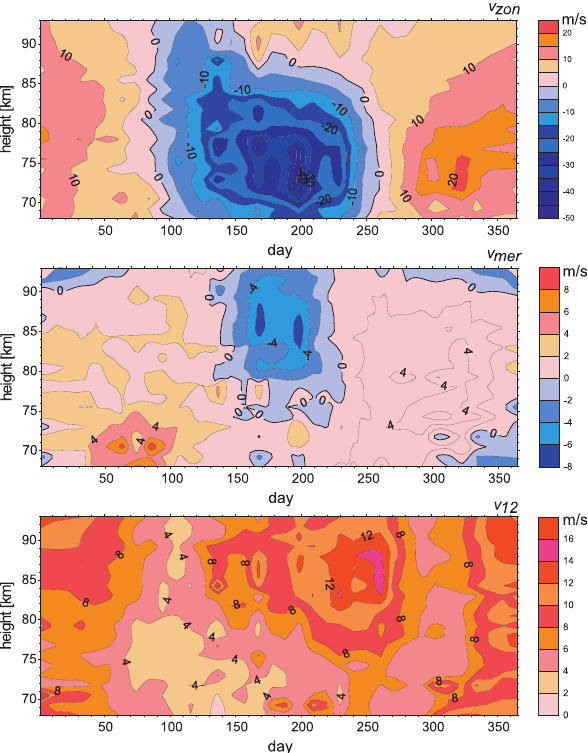
Fig. 1. Mean height-time cross section of the zonal wind (upper part), the meridional wind (middle part) and the amplitude of the semidiurnal tidal component (lower part) deduced from MF-radar measurements at Juliusruh between 1990 and 2005.